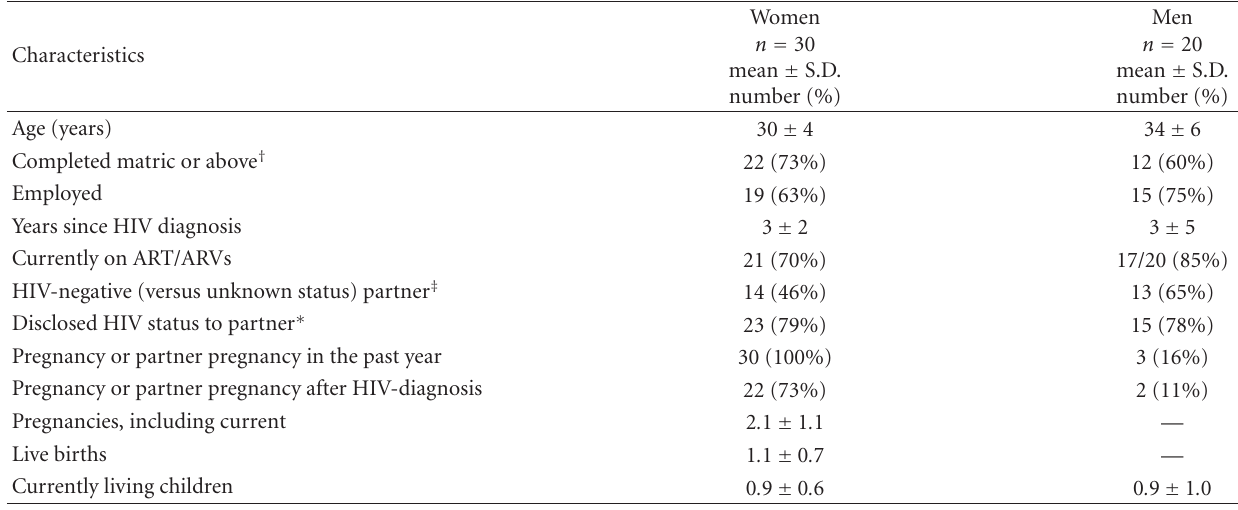
Table 1: Study population